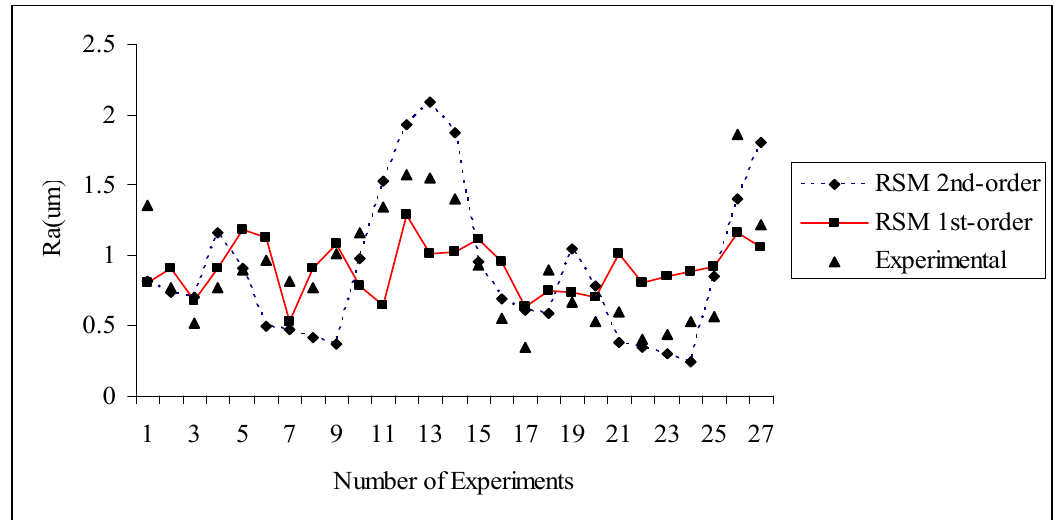
Figure 2. Comparison between the experimental and predicted results.